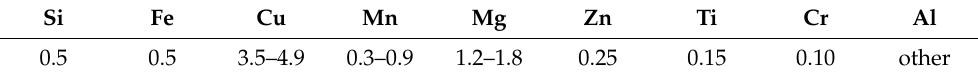
Table 1. Chemical composition of 2024 aluminum alloy (mass fraction wt.%).